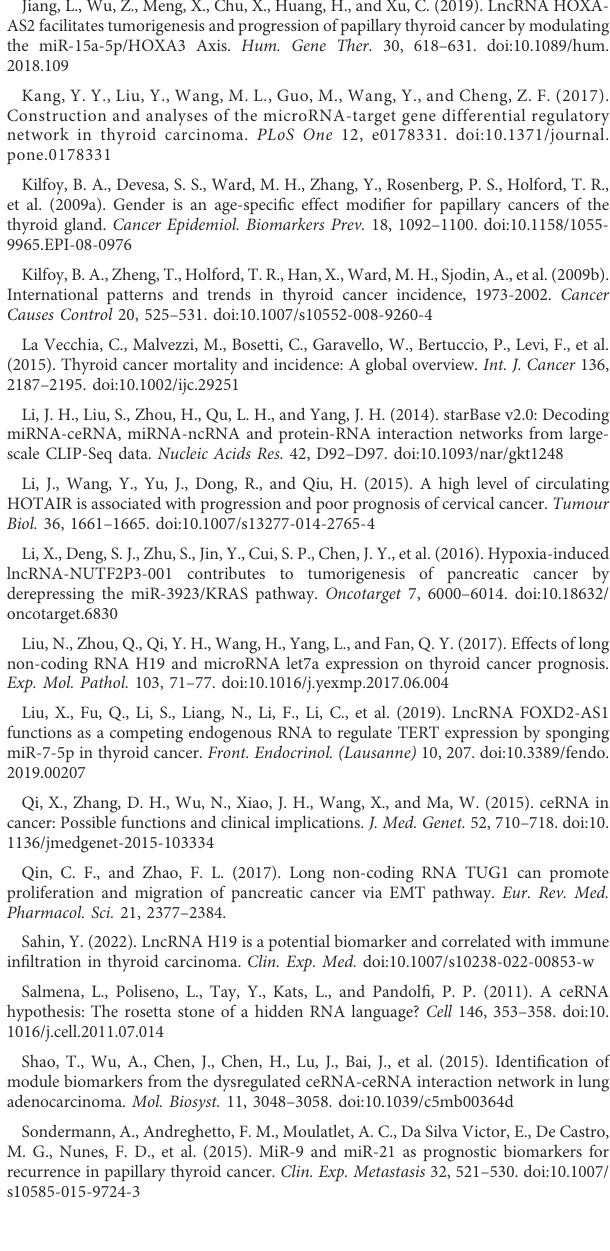
Enrichment analysis of THCArelated differentially expressed lncRNAs. SUPPLEMENTARY FIGURE S3 Immune cell in fi ltration of mRNAs in THCA. SUPPLEMENTARY FIGURE S4 Immune cell in fi ltration of miRNAs in